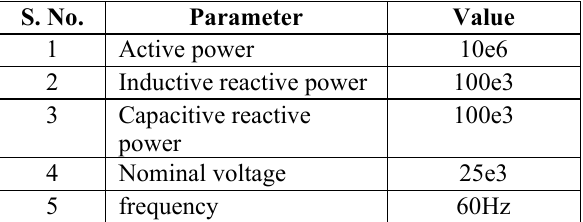
Table 4. Specifications of the RL load S. No.